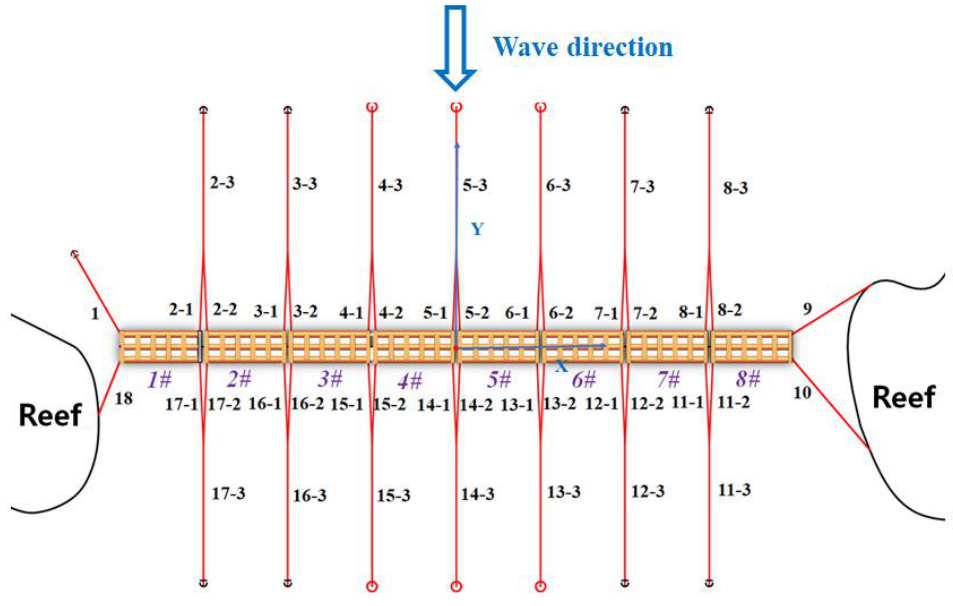
Figure 10. Serial number and origin diagram of mooring lines of 8 modules of breakwater models.